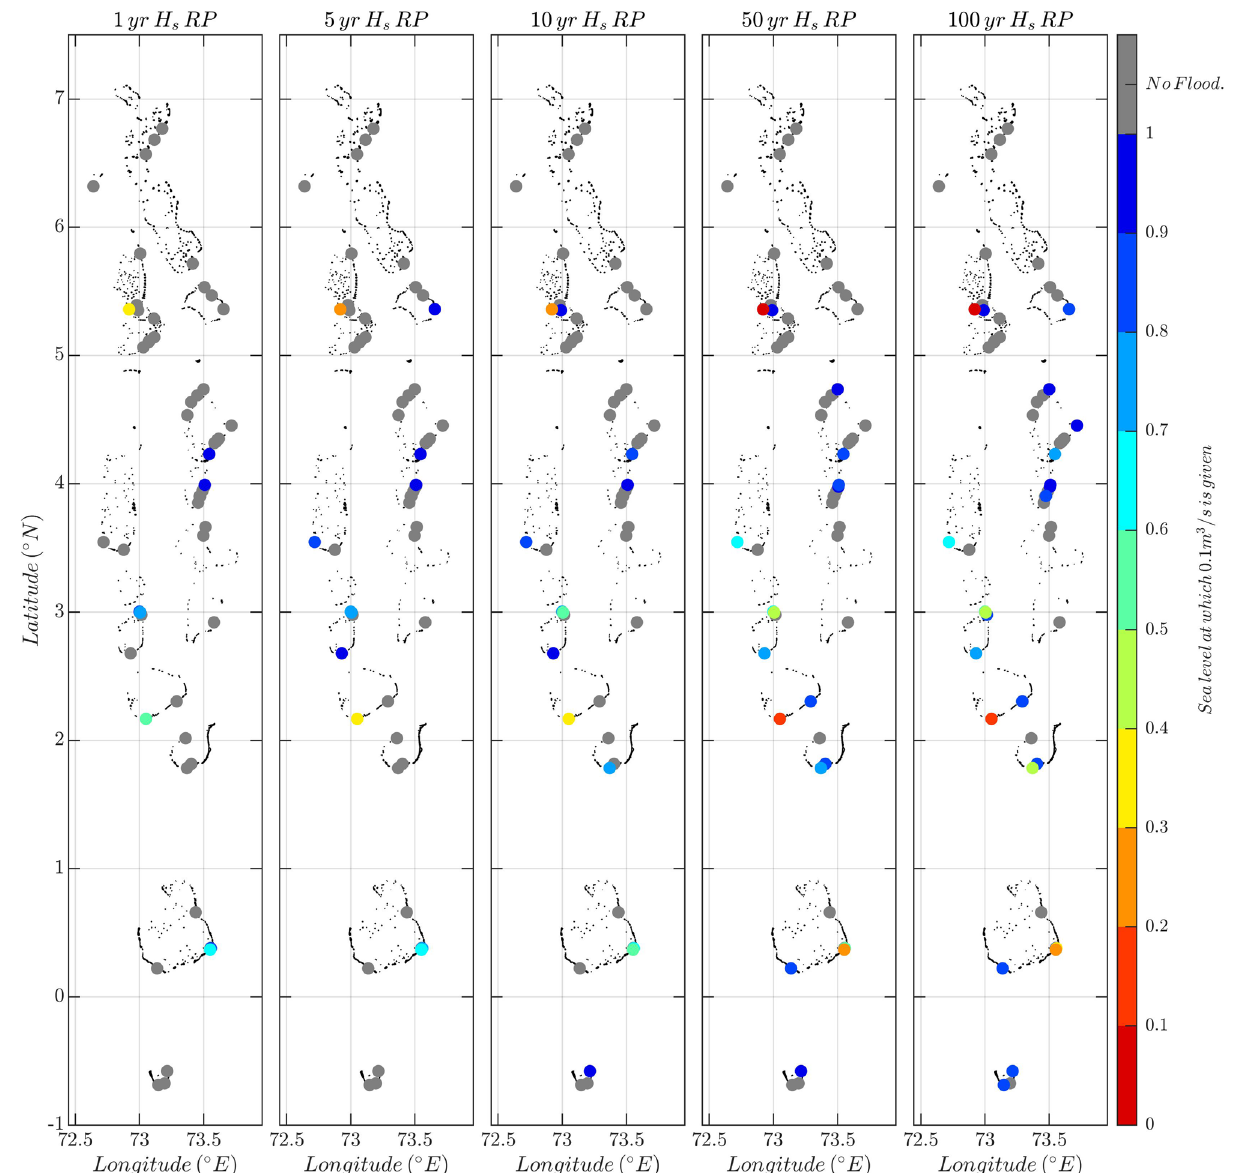
3 /s for different